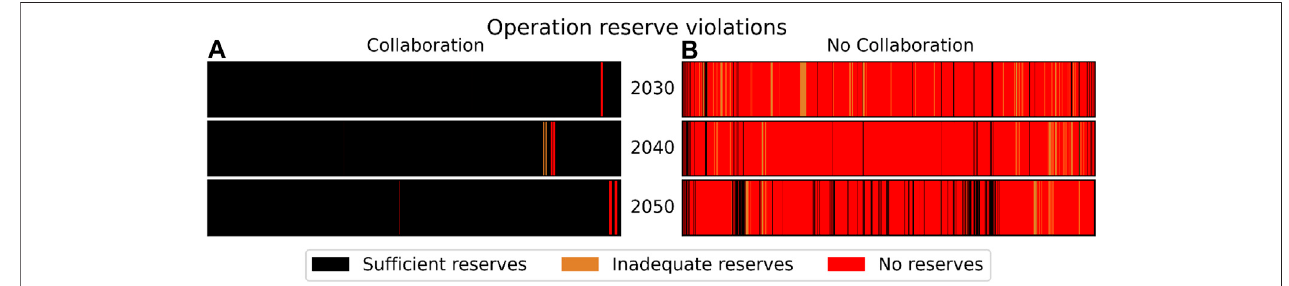
FIGURE 8 | The violations of minimum operational reserve capacity for the northern United Kingdom region for different years and scenarios. The red and orange lines indicate the hours of no or low reserves, respectively. Panel (A) shows the operational reserve violations for the Collaboration scenario, while panel (B) shows the violations for the No Collaboration